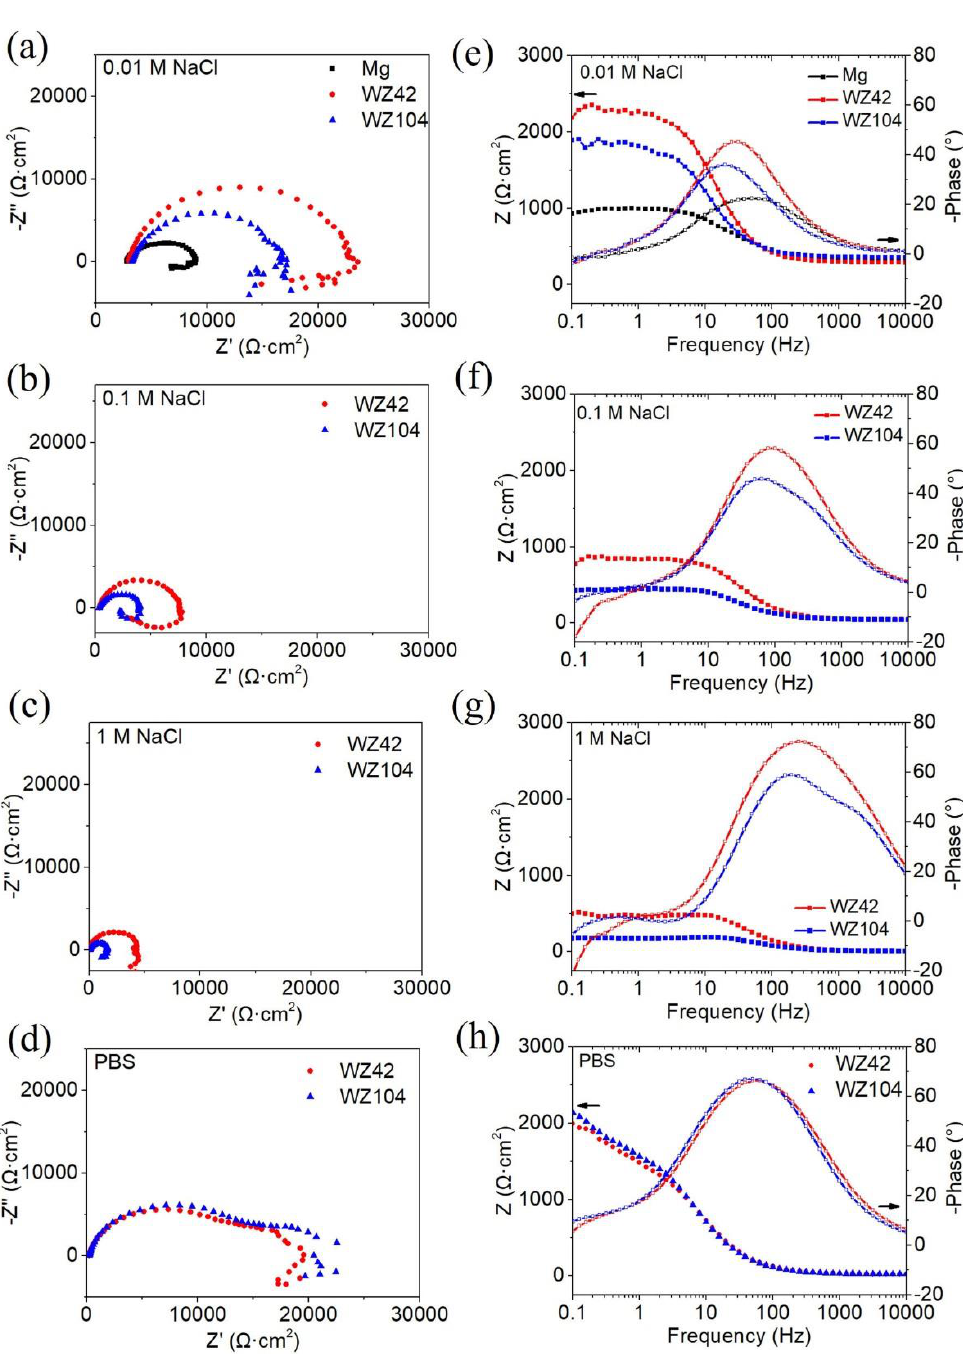
Figure 6. EIS results recorded for the investigated alloys after 1 h of immersion in 0.01 M NaCl, 0.1 M NaCl, 1 M NaCl, and PBS; ( a – d ) Nyquist plots, and ( e – h ) Bode plots.